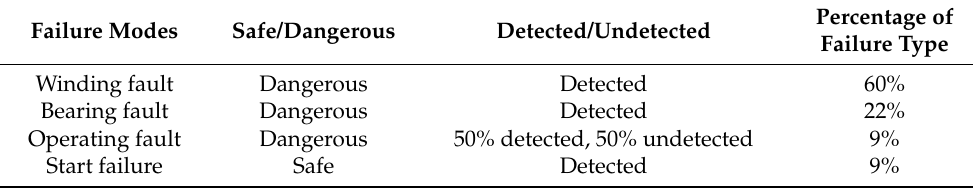
Table 5. Failure mode of motor.